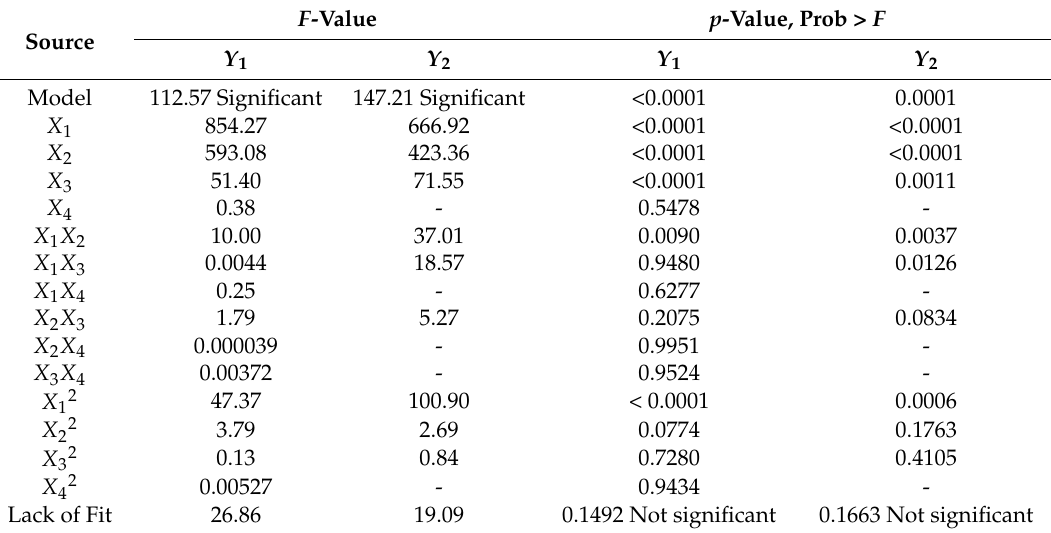
Table 5. Analysis of variance (ANOVA) for response surface quadratic